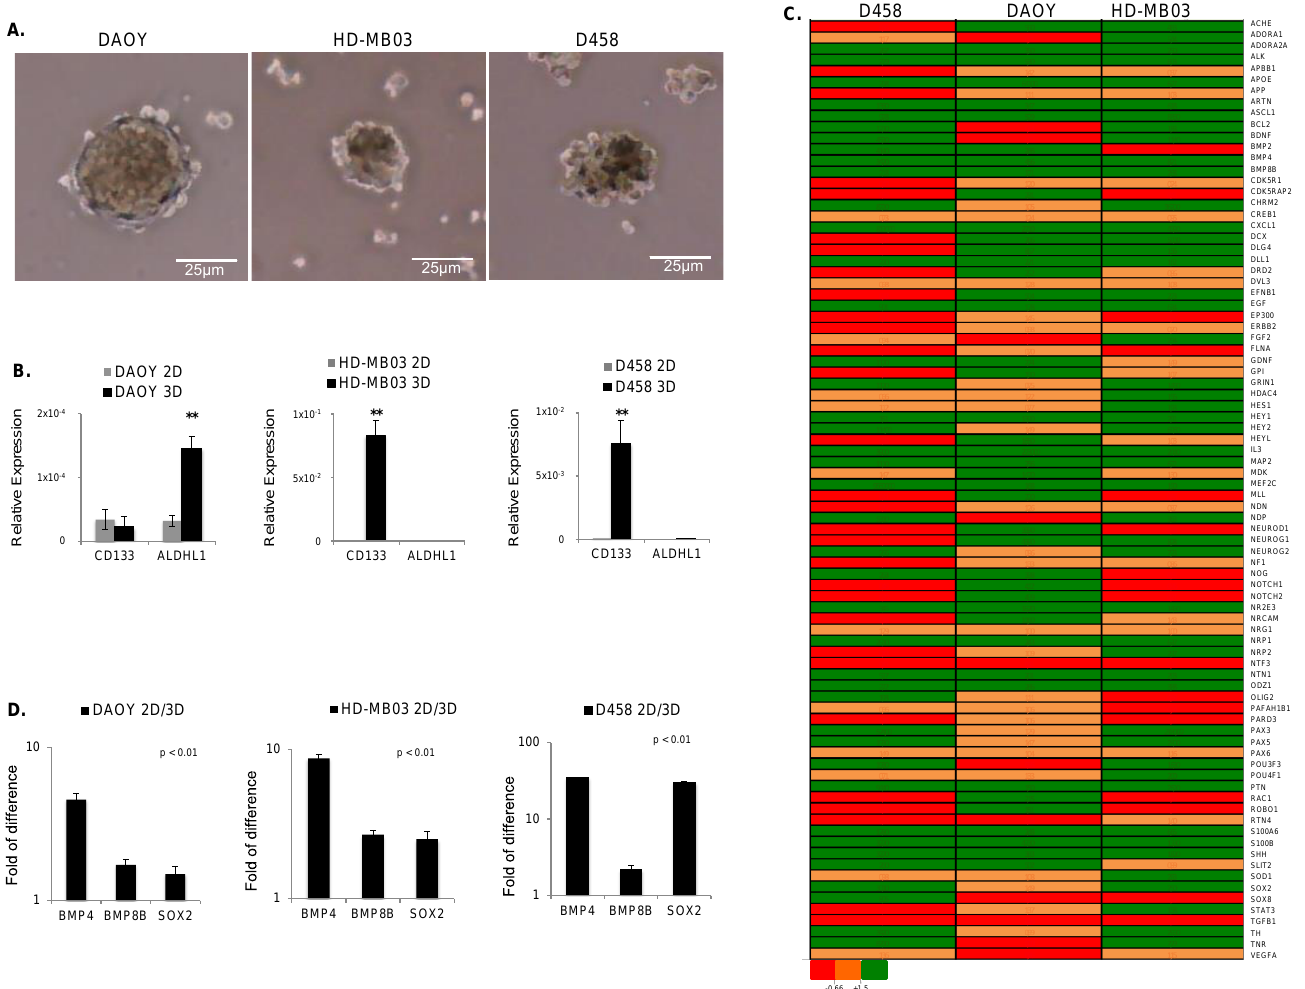
Figure 1. MB tumorsphere(s) generated from cell lines as indicated. ( A ) Representative images of spheroids generated from DAOY, HD-MB03, and D458 cell lines as indicated. ( B ) qRT-PCR analysis of brain CSC-related markers showing the relative expression of CD133 and ALDH1 in adherent (2D) and spheroid (3D) cells generated from DAOY, HD-MB03, and D458 relative to GAPDH (n = 3 biological replicates). ** p < 0.01, according to two-tailed paired Student’s t-test. Data are the mean ± SD. ( C ) Heatmap of RT2 profiler PCR arrays showing the differentially regulated genes in all three cell lines as shown. The gene expression level is shown as the fold change in 3D relative to 2D and normalized to the expression of housekeeping genes ACTB. ** p < 0.01. ( D ) RT2 profiler PCR array analysis for DAOY, HD-MB03, and D458 showing the gene expression level of BMP4, BMP8B, and SOX2 expressed as the fold change in tumor sphere(s) (3D) compared to (2D) and normalized with the housekeeping genes ACTB. p < 0.01 Data are the mean ±